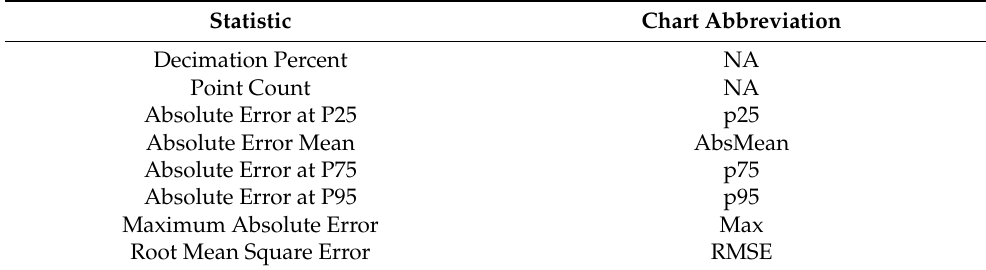
Table 2. Statistical parameters collected for each decimation